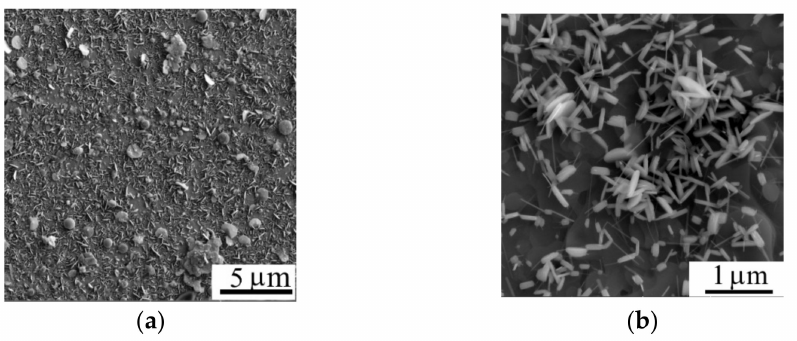
Figure 3. ( a , b ) SEM images of the surface of the WSe 2 film (two magnifications) obtained by off-axis PLD on the surface of C(B)/Al 2 O 3